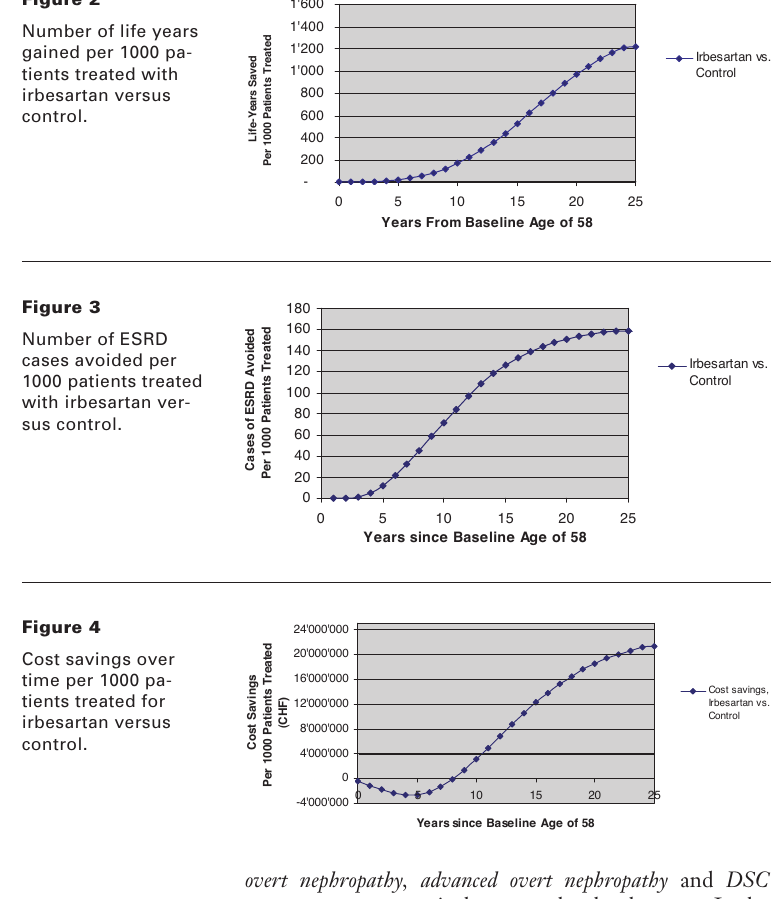
Figure 4 Cost savings over time per 1000 pa- tients treated for irbesartan versus control.